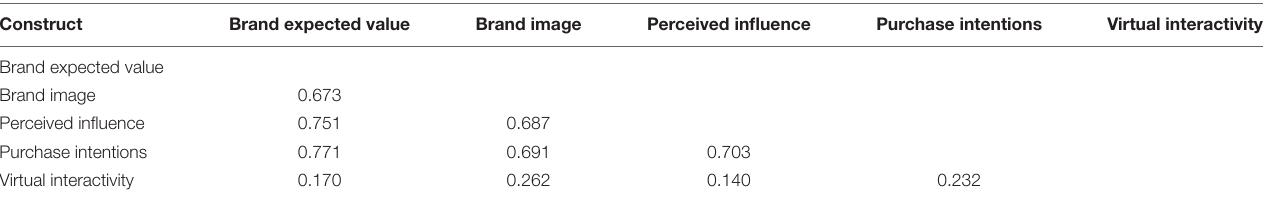
TABLE 3 | Discriminant validity (HTMT <